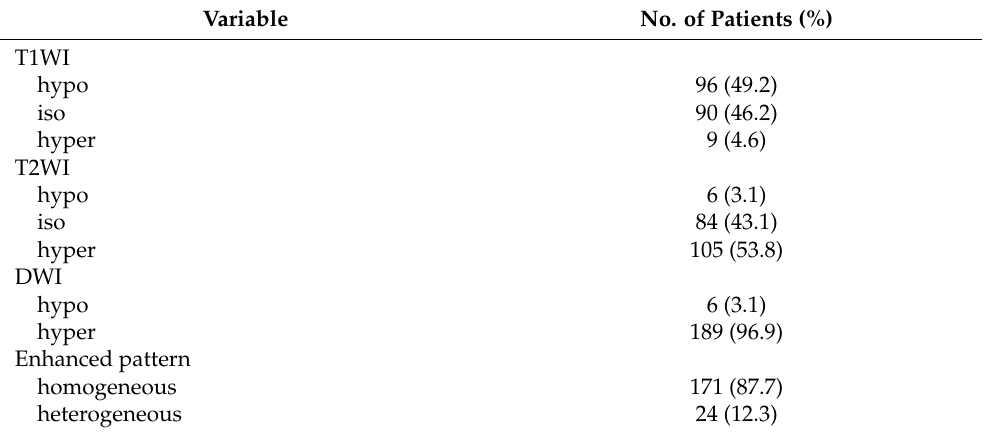
Table 7. Summary of radiological manifestations.